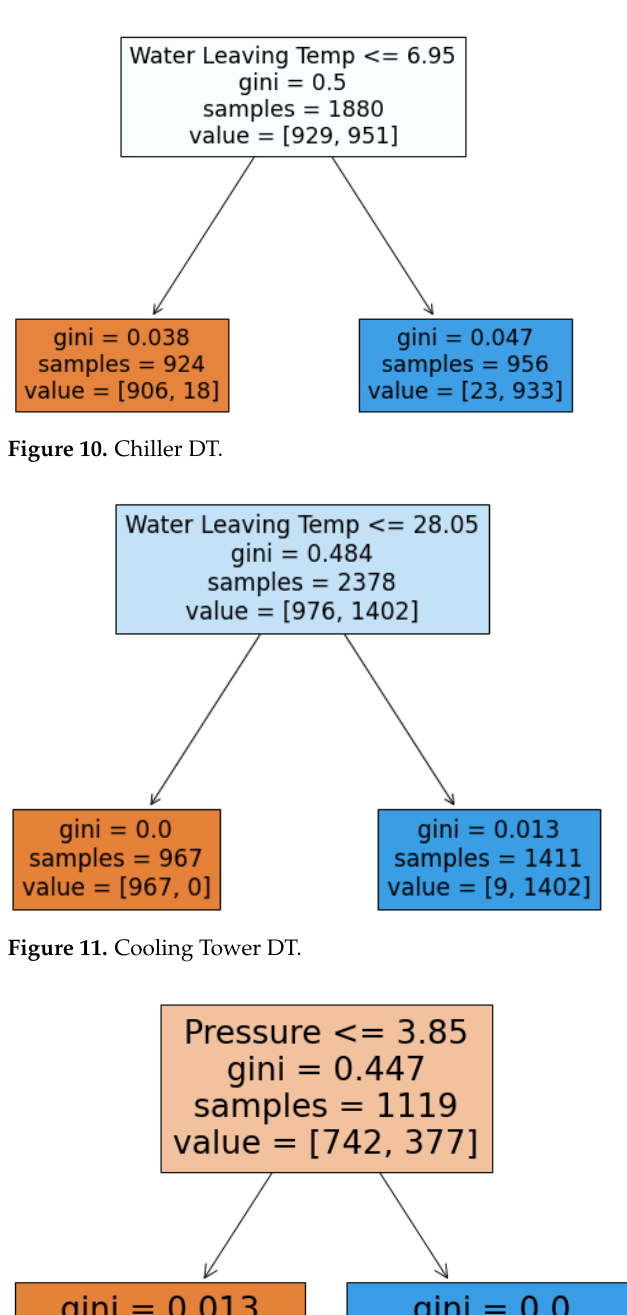
Figure 9. Chiller DT without Pruning.